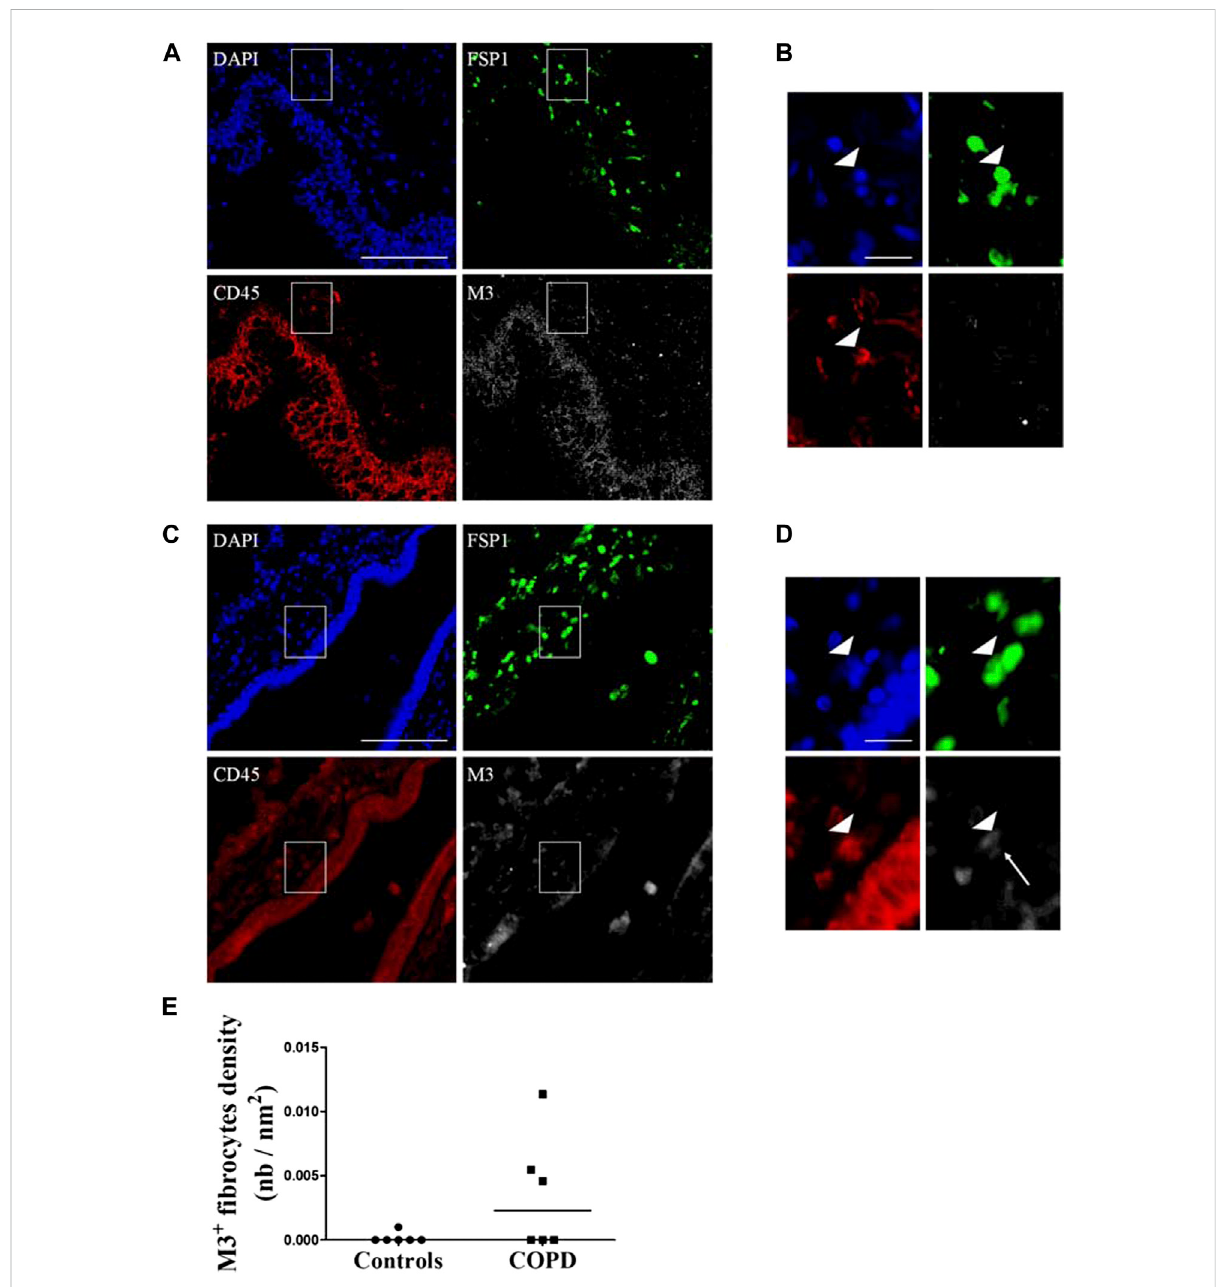
FIGURE 4 Identi fi cation of M3-expressing fi brocytes in the lungs of COPD patients and healthy subjects. Peri-bronchial fi brocytes are identi fi ed as double-positive FSP1+ (green) CD45 + (red) cells. M3 staining is represented in white and nuclei are stained with DAPI (blue). (A) representative triple immunostaining of a healthy subject ’ s lung tissue. Scale bar, 100 µm. (B) . Close-up view of the sub-epithelial region indicated in A (white square). Arrowheadindicatea fi brocyte,identi fi edasadoublepositiveFSP1-CD45cell,withoutM3expression.Scalebar,20 µm. (C) representativetriple immunostaining of a COPD patient ’ s lung tissue. Scale bar, 100 µm. (D) . Close-up view of the sub-epithelial region indicated in C (white square). Arrowhead indicate a fi brocyte, identi fi ed as a double positive FSP1-CD45 cell, expressing M3 (white arrow). Scale bar, 20 µm. (E) . Quanti fi cation of M3 + fi brocytes densities as represented by the number of peri-bronchial triple-positive cells divided by the area of lamina propria